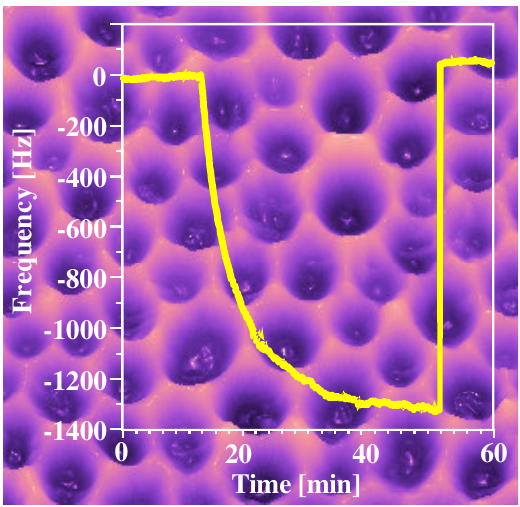
Figure 7: AFM-image of a yeast-imprinted polyurethane and sensor effect of that material towards a suspension of the template microorganism in